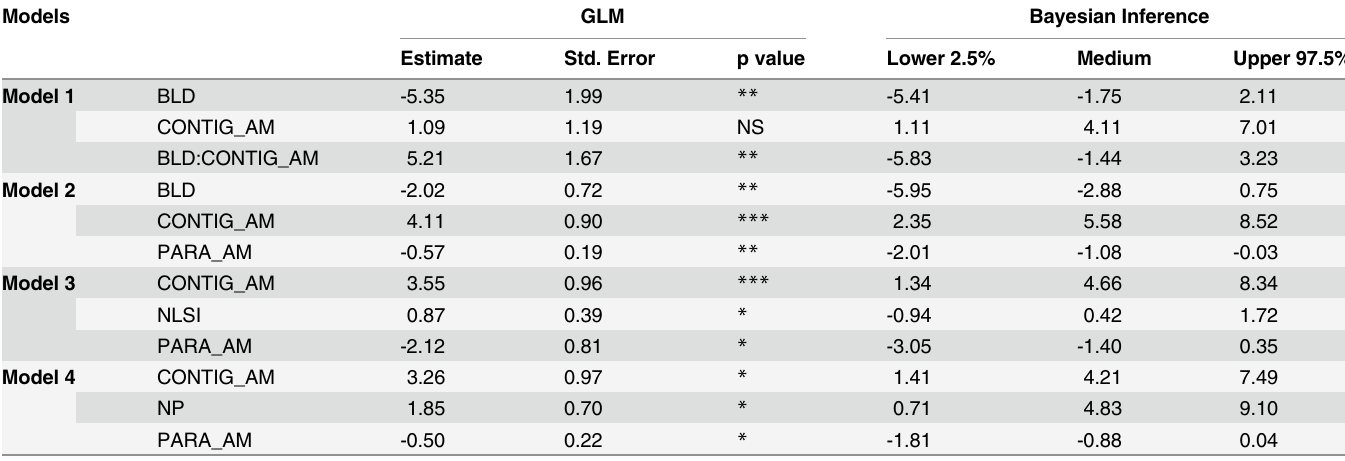
Table 3. Coefficients of the top three GLM and the creditable interval based on Markov Chain Monte Carlo sampling. Models